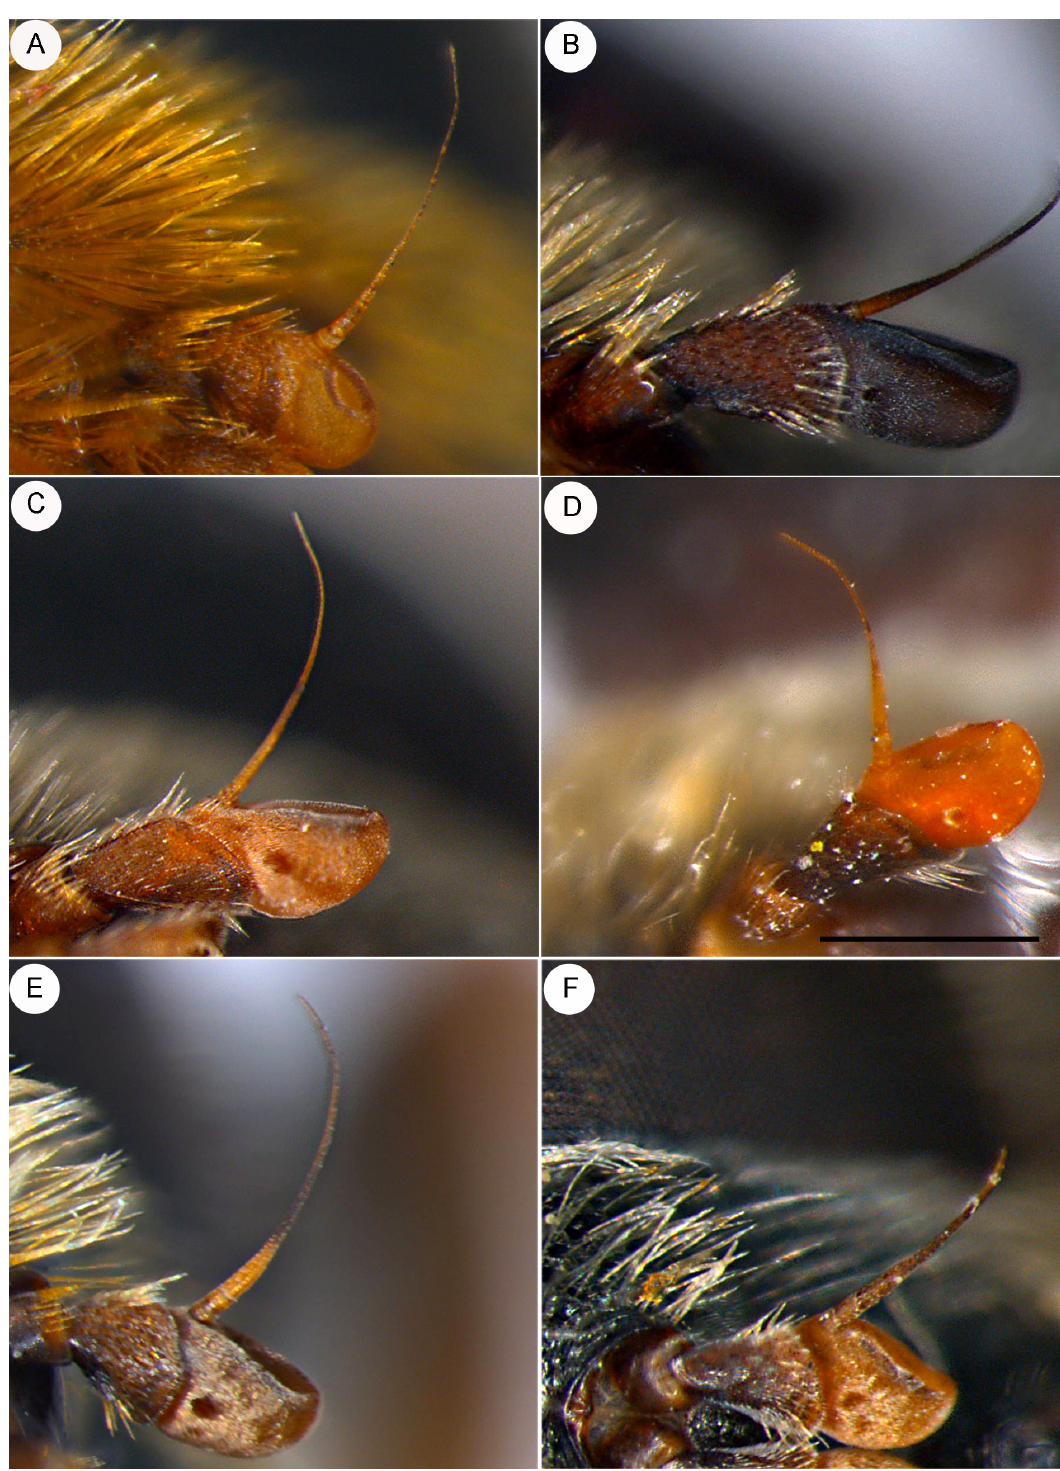
Fig. 4. Male antenna, lateral view. A . Merodon bombiformis Hull, 1944 (FSUNS; FSUNS ID ZA2_079). B . M. multifasciatus Curran, 1939 (USNM; FSUNS ID 04512). C . M. vittatus Vujić & Likov sp. nov., holotype (NBCN; FSUNS ID 04085). D . M. zebra Vujić & Radenković sp. nov. paratype (NBCN; FSUNS ID 05174). E . M. lotus Vujić & Radenković sp. nov., paratype (FSUNS; FSUNS ID ZA6_066). F . M. nasicus Bezzi, 1915 (TAUI; FSUNS ID 04972). Scale bar = 2